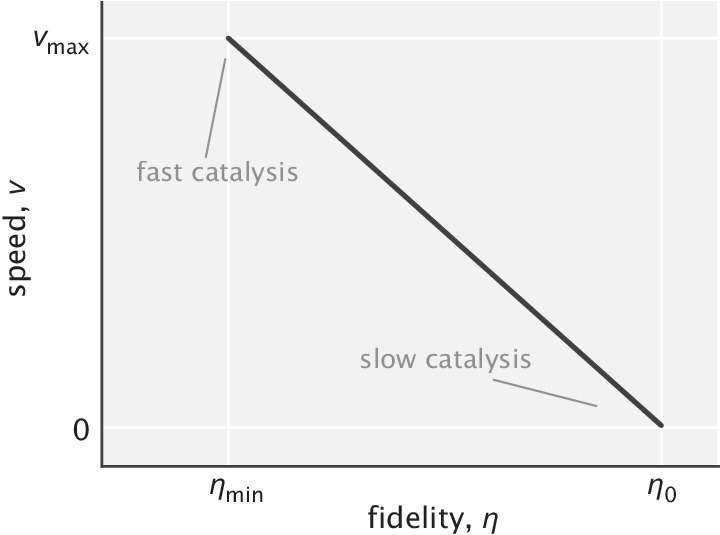
Linear trade-off between speed and fidelity when tuning the rate of catalysis.ηmin is the fidelity in the fast catalysis limit and is up to ηeq lower than η0 (based on the results of the previous section). Linear scale is used for both axes.